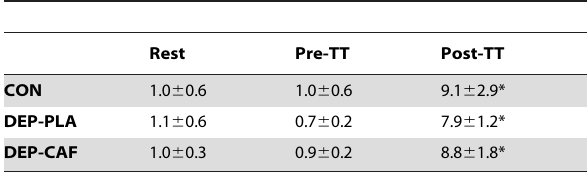
Table 3. Mean and SD for lactate concentration at rest, and pre and post the 4-km cycling